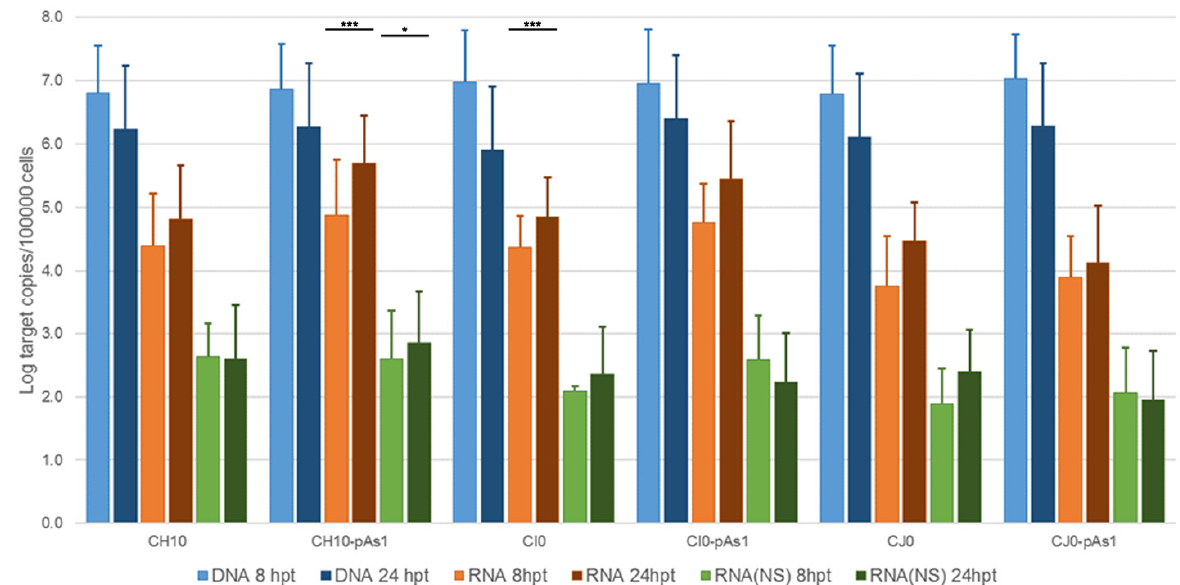
Figure 2. Viral nucleic acids in UT7/EpoS1 cells, transfected with CH10 and CH10-pAs1 derived inserts. Log amounts of target copies (viral DNA, total RNA, NS1 mRNA), normalized to 10 5 cells, at 8 and 24 hpt. Mean and std of duplicate determinations for two different experiments. Two-way